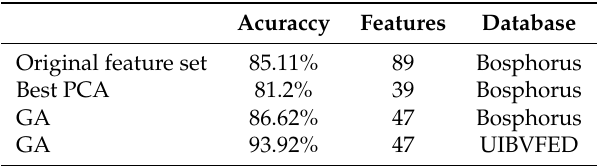
Table 16. Mean of